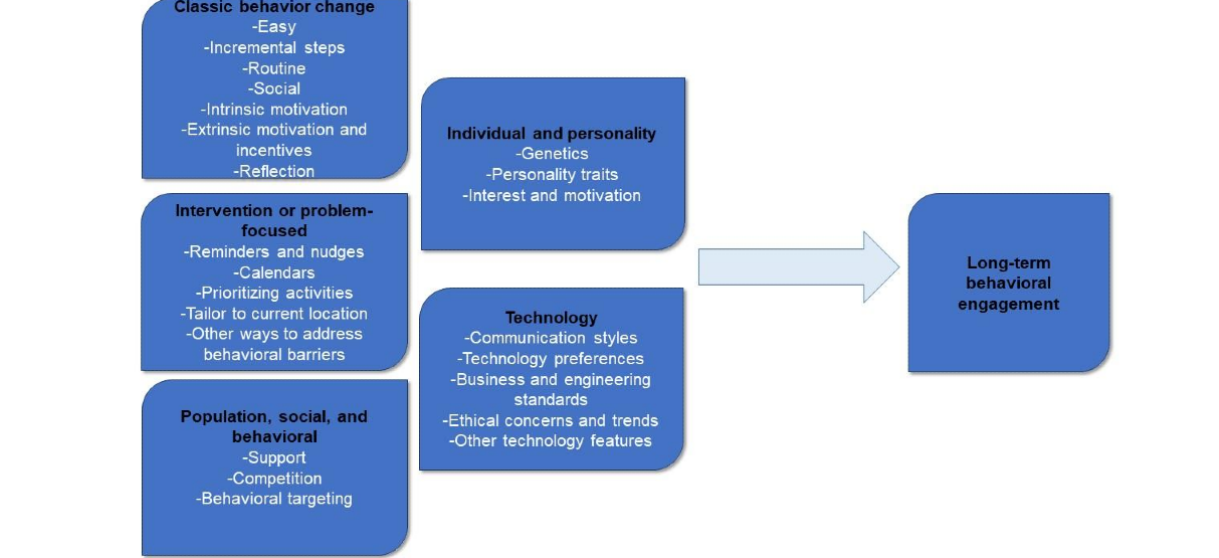
Figure 1. Adaptive Behavioral Components Theory (ABC) for Technology-based Interventions. By helping researchers to consider these five high-level components, the model provides guidance on how to plan for the needs and potential changes during a technology-based health